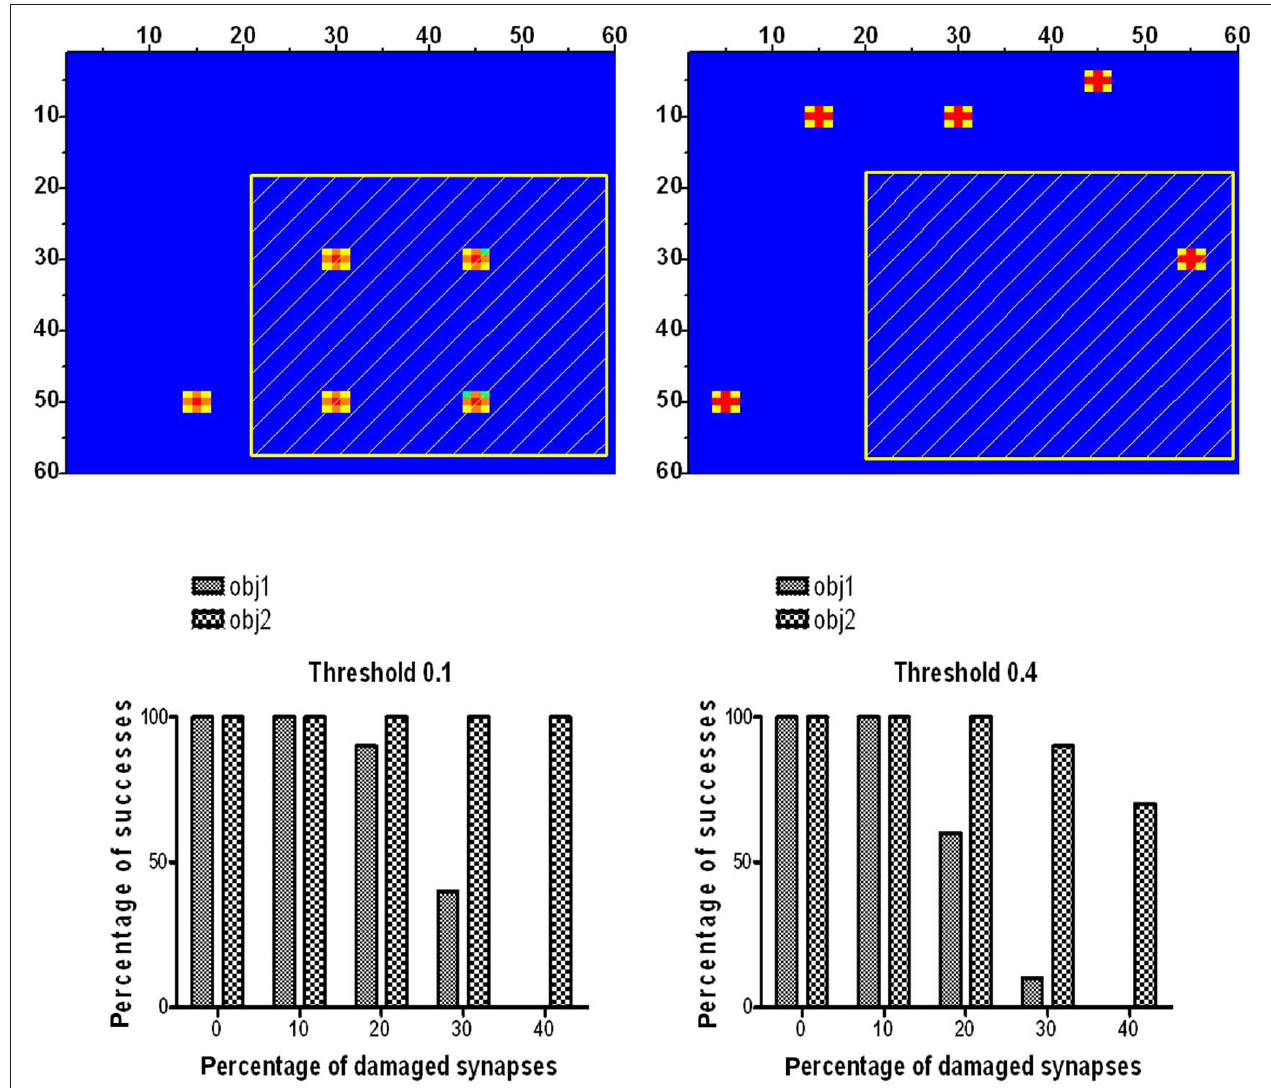
region. The bottom panels represent the percentage of success in recognition of obj1 and obj2, as a function of the percentage of damaged synapses. Two different thresholds for word recognition in the lexical area were used. It is worth noting that obj1 is frequently missed for a percentage of synapse damage greater than 20%, whereas the recognition of obj2 is quite robust despite synapse